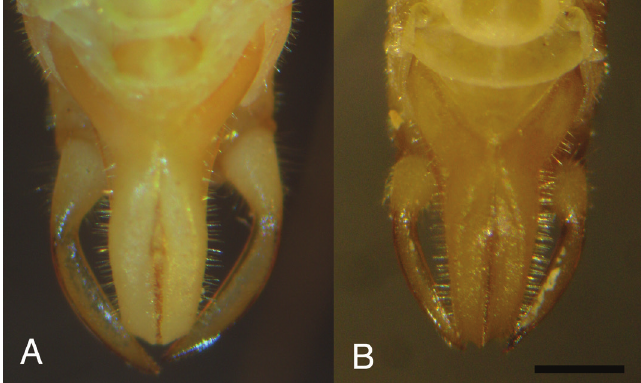
Figure 8. Ventral view of male subgenital plate. A. E. diuturna sp. n., B. E. fulva . Scale 1 mm.